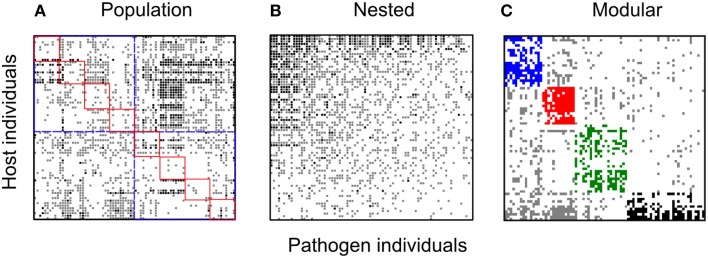
Bipartite spatial networks for the for the Linum-Melampsora BH network. Black squares indicate full resistance, gray squares indicate partial resistance, and white squares indicate full susceptibility. All panels are formed from the same base dataset but sorted in different ways so as to test different network hypotheses: (A) sorted by population and ecotype of origin. Host and pathogen interactions corresponding to the same population are indicated by red squares while the ecotypes are shown by the blue squares; (B) sorted to maximize nestedness; and (C) sorted to maximize modularity. For nestedness, the network is significantly nested (NODF; P < 0.001). For the modularity sorting, discrete modules are shown in different colors (blue, red, green, black). Four modules could be identified in this network with the P-value for observed modularity less than 0.0001.